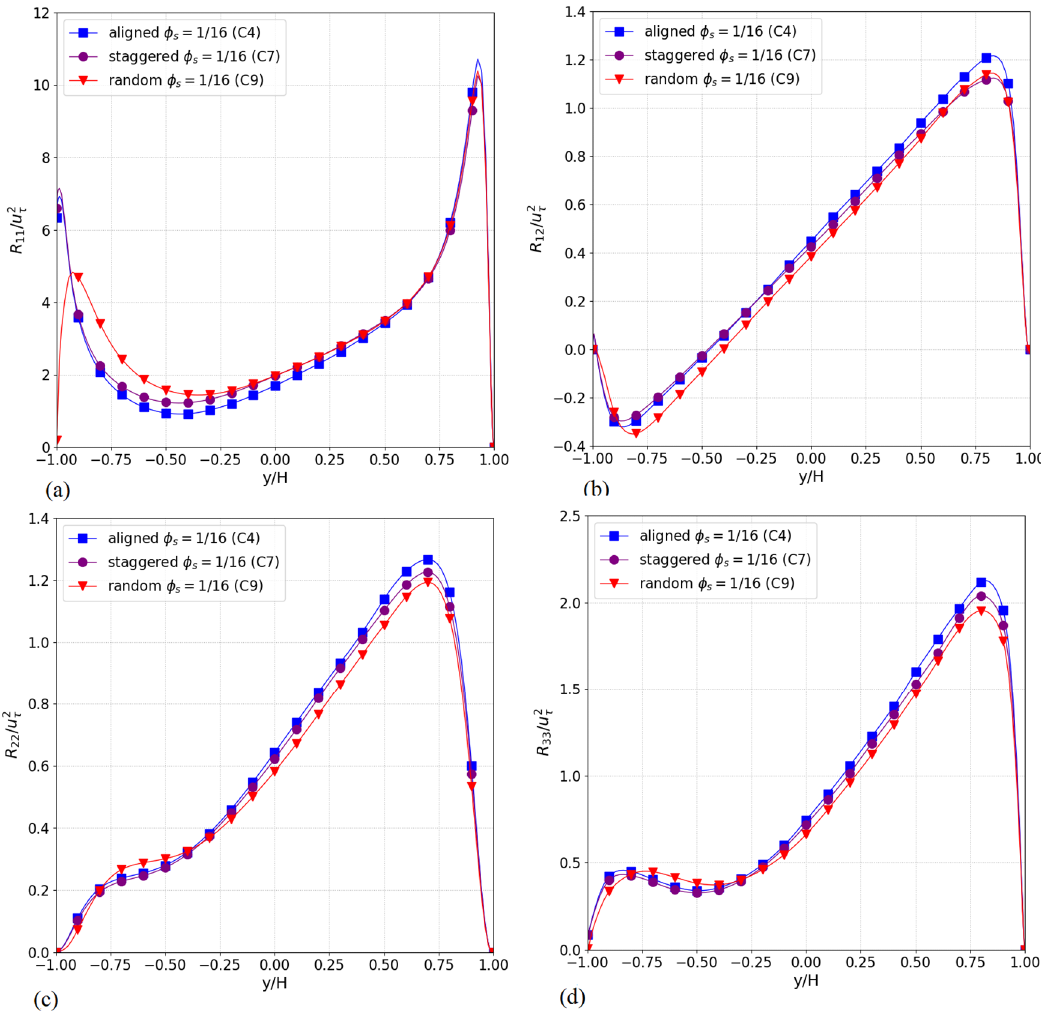
Figure 14. Comparison of Reynolds stress profiles for three different distributions at the solid fraction, φ s = 1 16 : ( a ) R 11 , ( b ) R 12 , ( c ) R 22 , and ( d ) R 33.